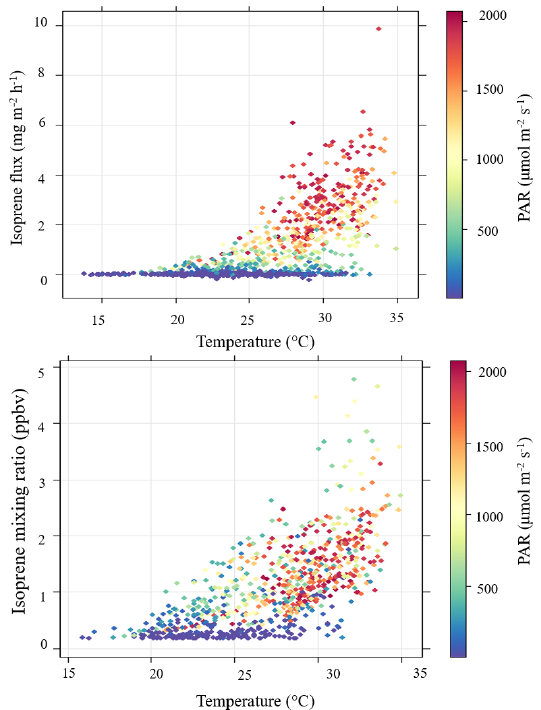
Figure 8. The relationship between temperature ( ◦ C) and iso- prene fluxes (mgm − 2 h − 1 ) and mixing ratios (ppbv), coloured according to the magnitude of photosynthetically active radiation (µmolm − 1 s − 1 ) .